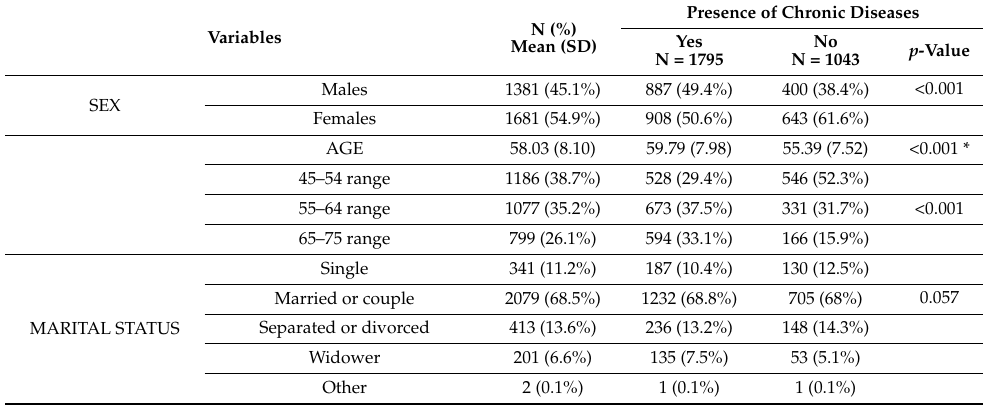
Table 1. Description of the sample in terms of sociodemographic variables, presence of chronic diseases, depression and adherence to the Mediterranean diet. Comparison according to the presence of chronic